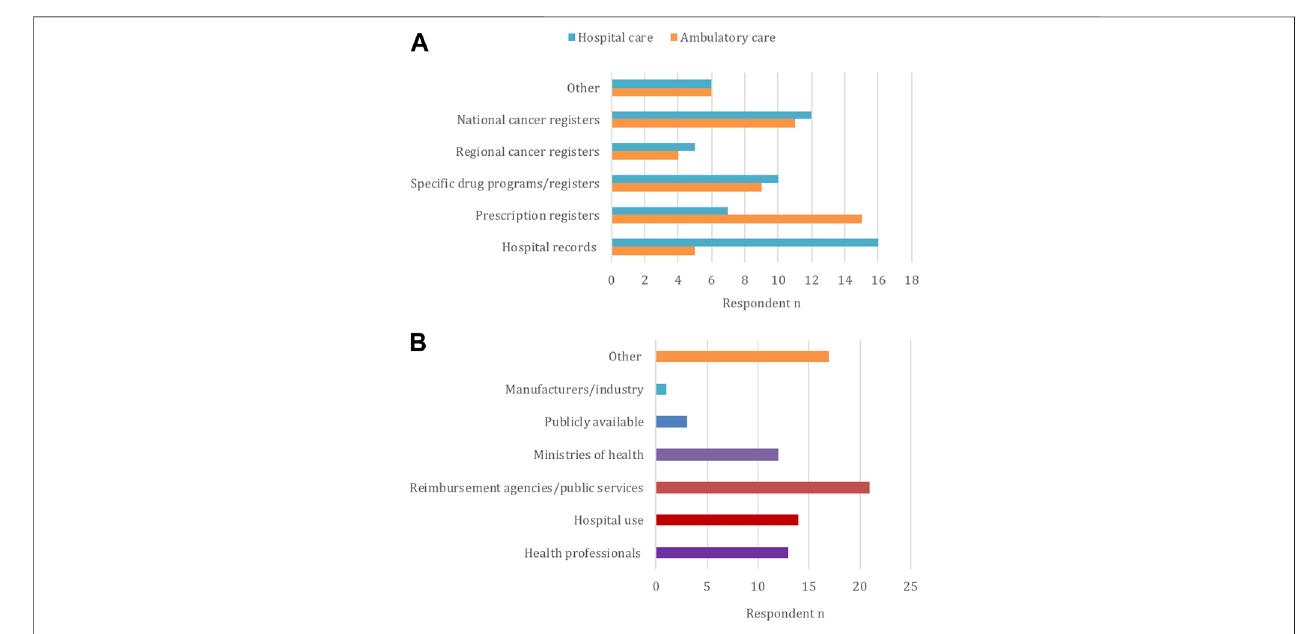
FIGURE 3 | Types of databases for oncology ( (A) , n = 24) and entities that may use the collected data ( (B) , n = 25), according to the participants.